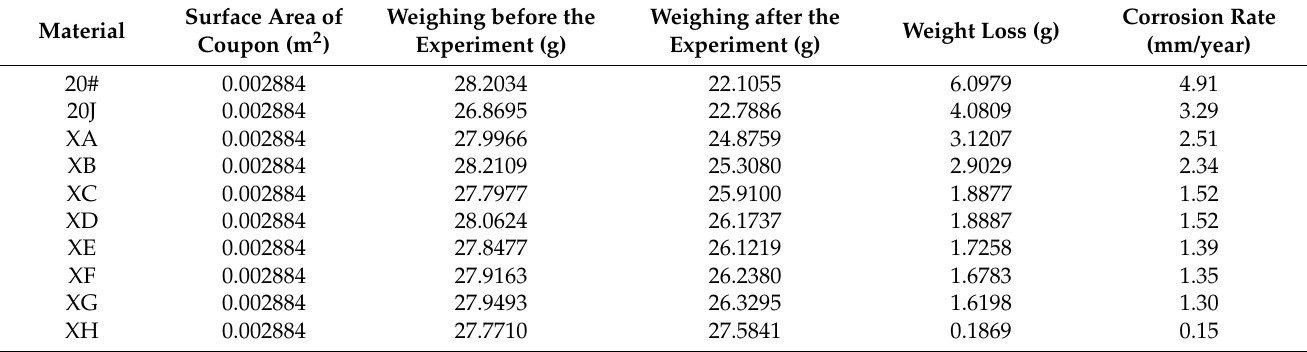
Table A3. Corrosion rate in the case of CO 2 partial pressure of 1 MPa and 80 ◦